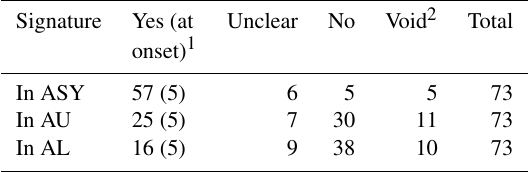
Table 1. Survey of 73 flare events with the > X2 class.